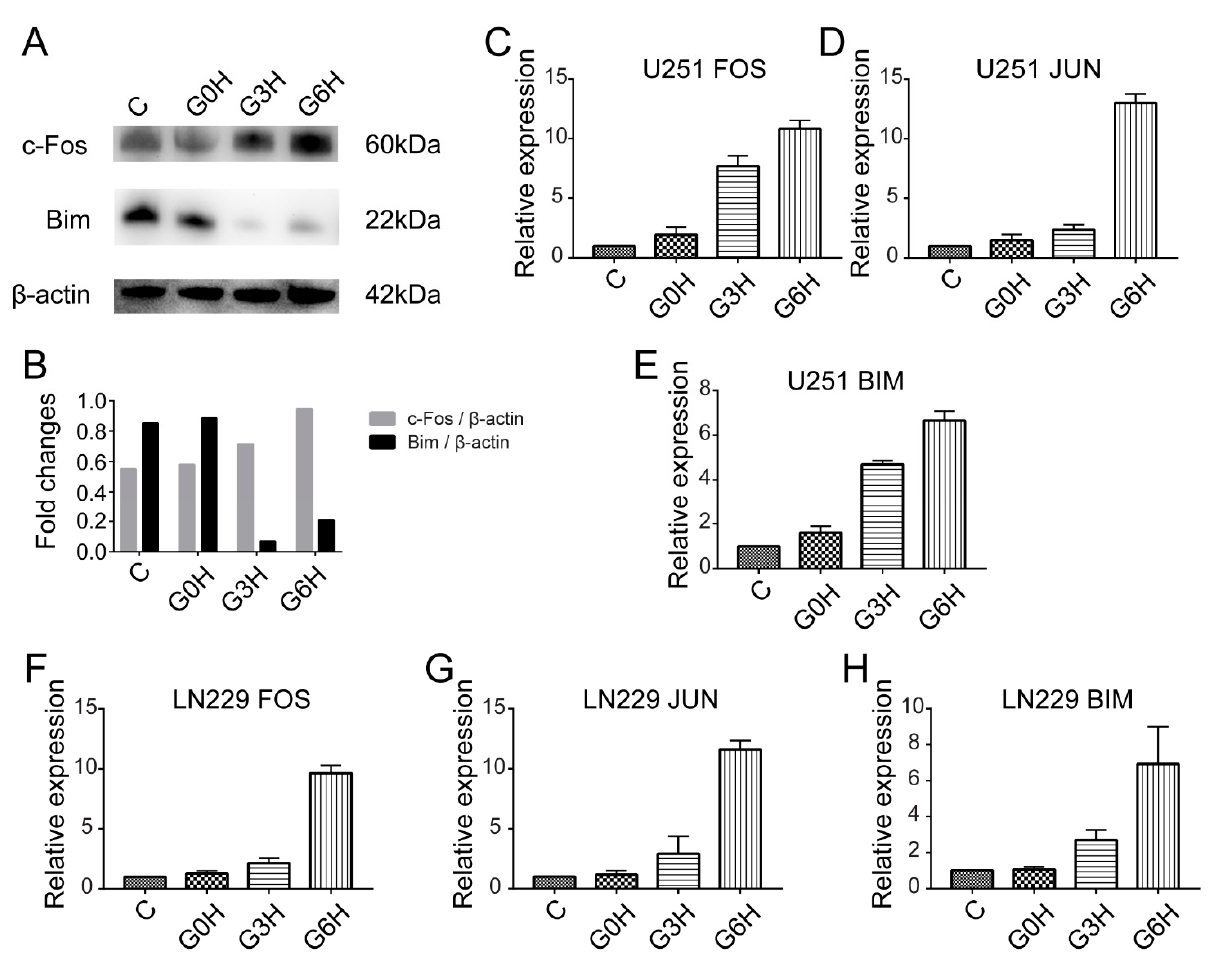
Figure 6. Upregulation of transcription factor AP-1 and upregulation of Bim (Bcl2l11) expression after electroporation. Western blot results ( A ) and analysis ( B ) of c-Fos and Bim in samples collected at 0 h after sham treatment, 0 h, and 6 h after electroporation in U251 cells. c-Fos was consistently upregulated. Bim showed high basal expression and did not significantly reduce instantly after the treatment and then dropped to the lowest expression 3 h later. Expression of Bim was gradually upregulated 6 h later. qPCR results ( C – H ) of FOS ( C , F ), JUN ( D , G ), and Bim ( E , H ) in two different cells, U251 ( C – E ) and LN229 cells ( F – H ), all showed gradual upregulation after electroporation, which was consistent with the sequencing results.